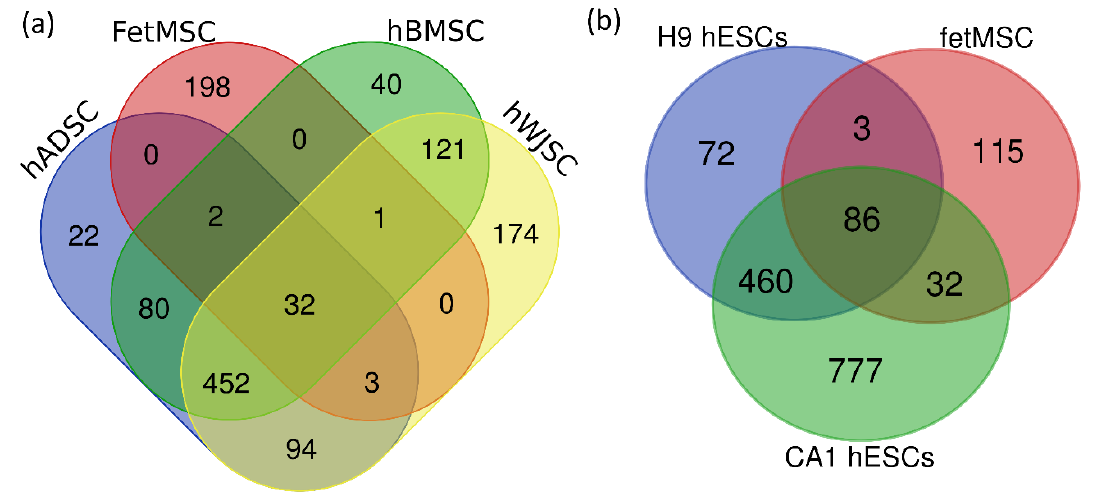
Figure 4. Venn diagram of the number of proteins shared between the FetMSCs secretome and previously published ( a ) three types of adult hMSCs secetomes [22] or ( b ) two types of hESCs secretomes [23].